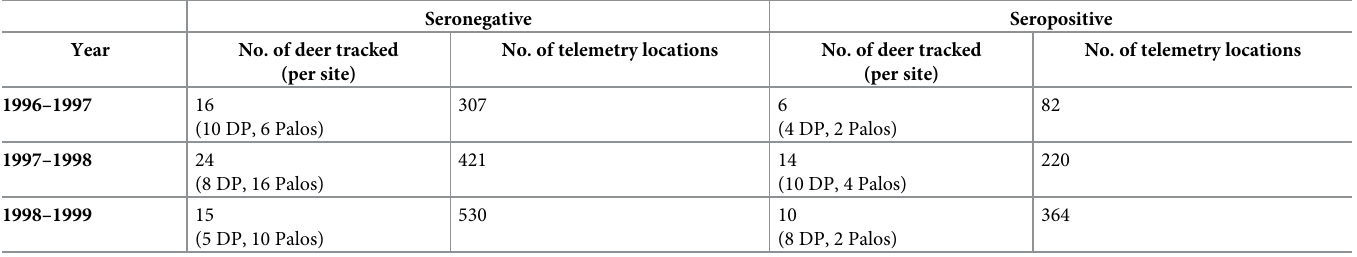
Table 1. The number of deer radio-tracked, number of deer per site (DP = Des Plaines), and number of telemetry locations for deer seronegative or seropositive for Jamestown Canyon virus in Cook County, Illinois (1996–1999). Seronegative Seropositive Year No. of deer tracked No. of telemetry (per site)